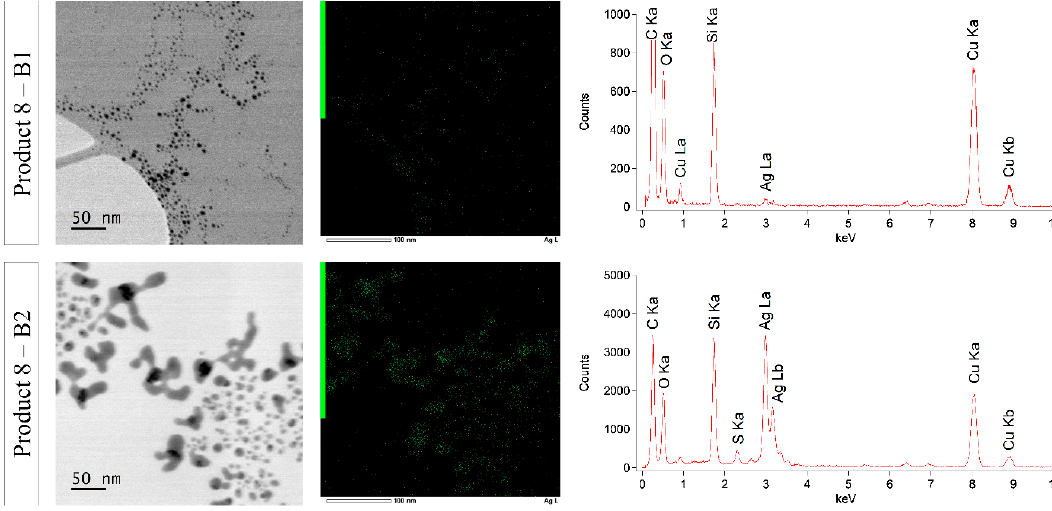
Figure 11. STEM ‐ EDX results of batches 1 and 2 of product 8. Figure 11. STEM-EDX results of batches 1 and 2 of product